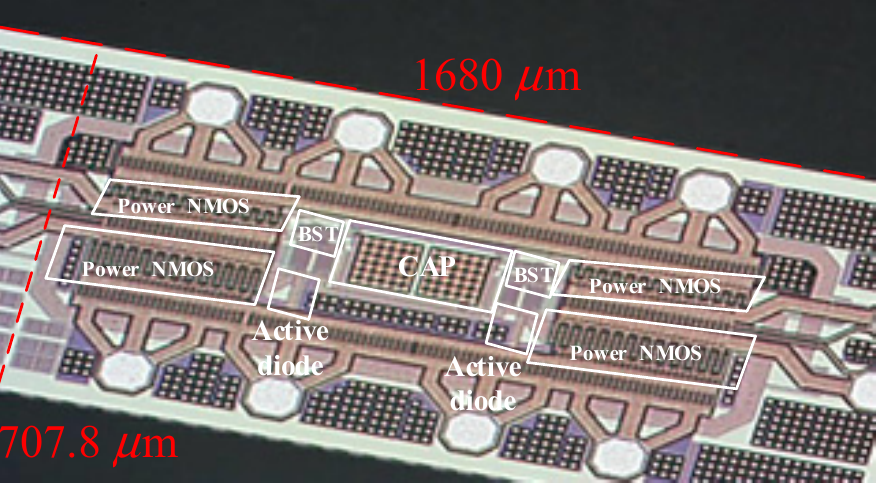
Figure 21. Chip die photo.